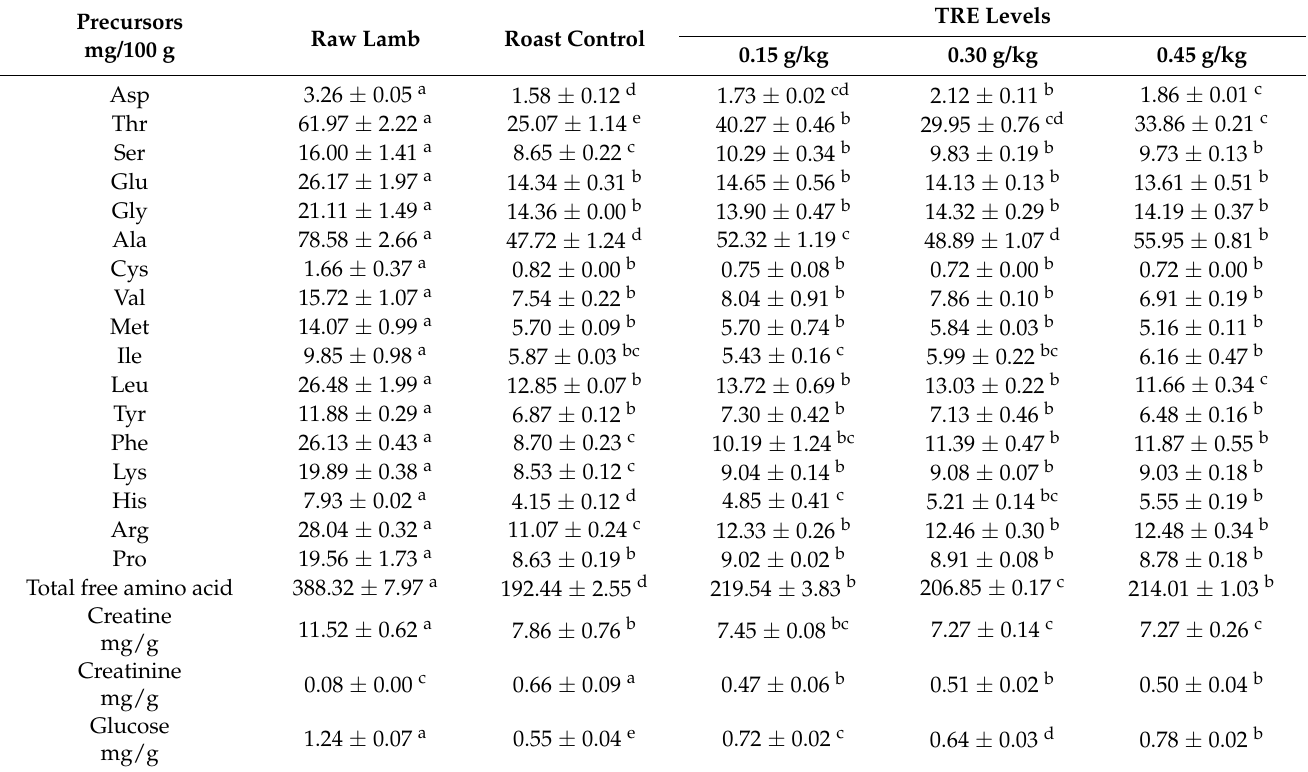
Table 2. Content of different precursors in roast lamb with different levels of TRE.